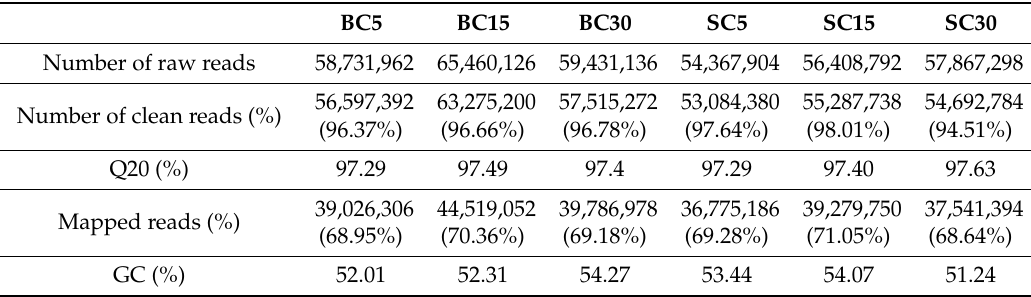
Table 2. Overall assembly statistics for the D. sinicus